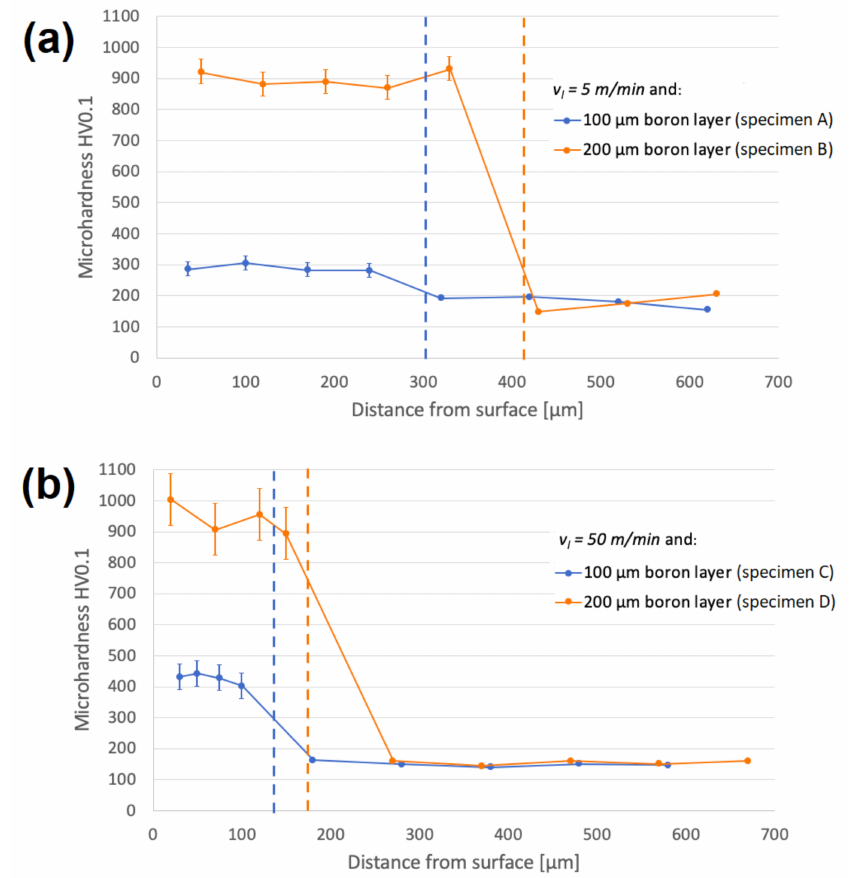
Figure 5. Microhardnessofboridedlayersindifferentdistancesfromsurface, alloyedwith: ( a ) v l = 5 m / min and ( b ) v l = 50 m / min.